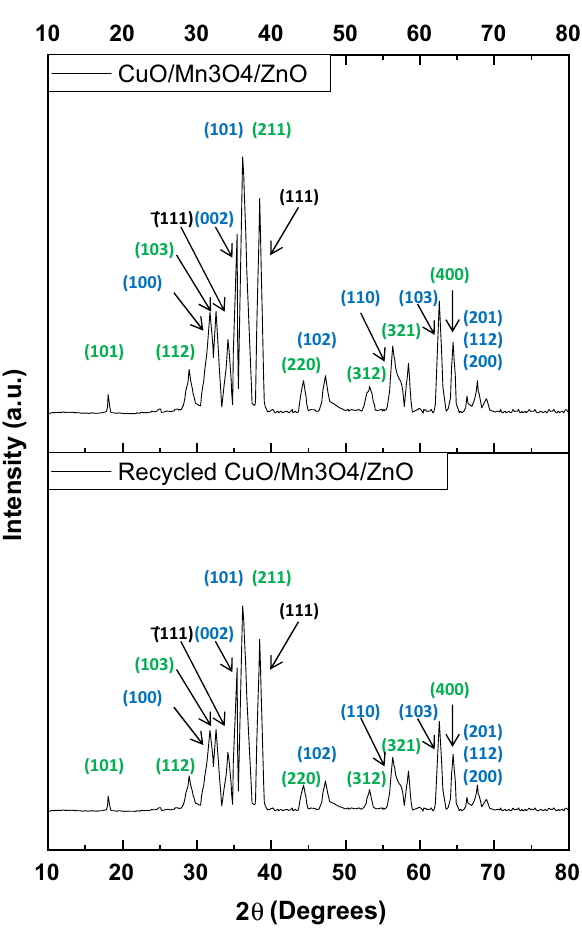
Figure 9. XRD patterns of CuO/Mn 3 O 4 /ZnO before and after